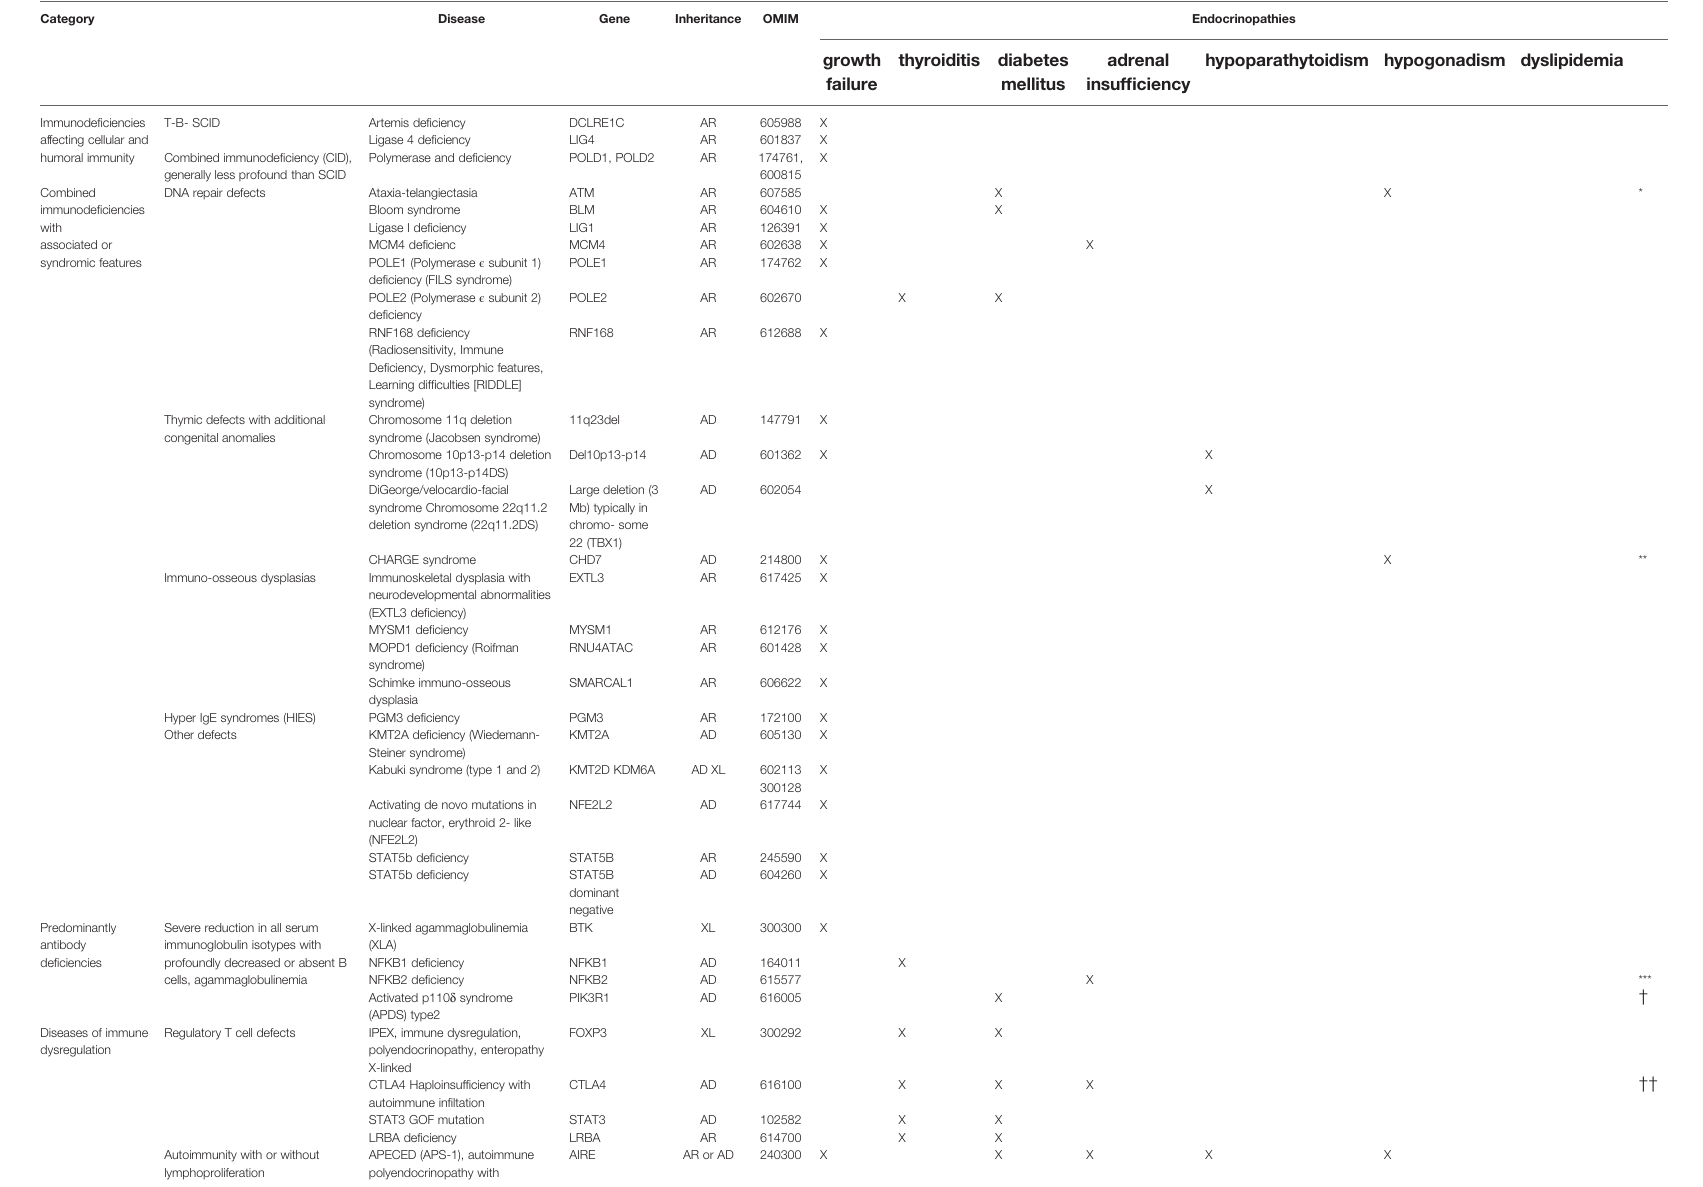
TABLE 1 | Modi fi ed the classi fi cation of the International Union of Immunological Societies Expert Committee according to complications of endocrinopathy (2).